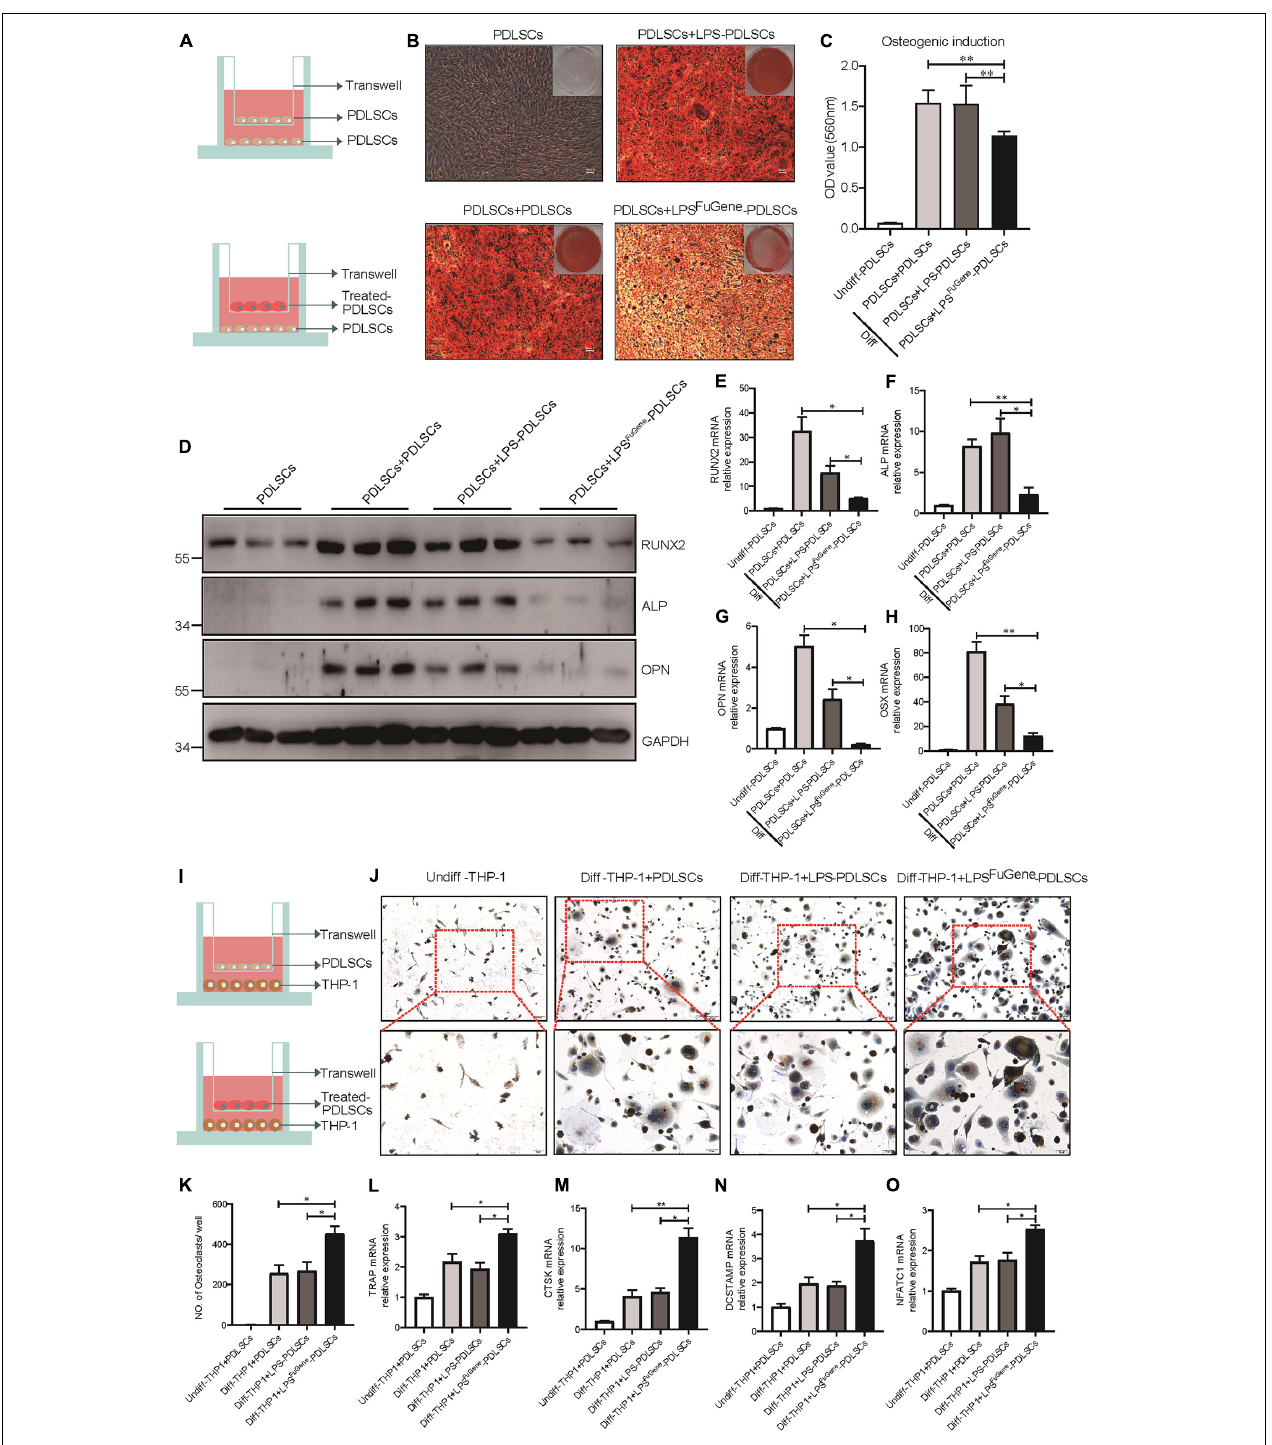
FIGURE 4 | The paracrine effect of PDLSC pyroptosis on osteoblast differentiation and osteoclast differentiation. (A) Schematic diagram of coculture design indicating the placement of PDLSCs with LPS, with LPS FuGene treatment, or without treatment on the transwell insert with the lower chamber containing healthy PDLSCs. (B–H) Cells in the cocultured transwell system were maintained in osteogenic differentiation medium for 21 days. PDLSCs in a single culture (without coculture) were maintained in MEM- α medium as a control. (B) Entire plate views and micrographs of alizarin red staining after culturing in osteogenic differentiation medium. (C) Quantification of the alizarin red staining results. (D) Immunoblots for RUNX2, ALP, and OPN in whole-cell lysates. GAPDH was used as a loading control. RUNX2 (E) , ALP (F) , OPN (G) , and OSX (H) mRNAs were subjected to real-time PCR analysis, and the expression levels were normalized to that of 36B4